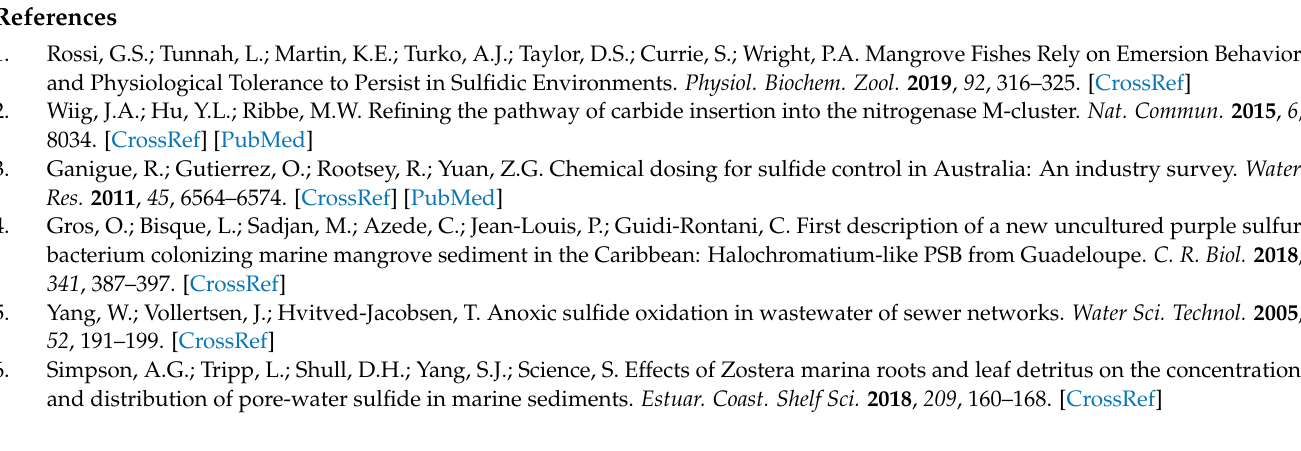
genes enriched in the NMS; Figure S4: Taxonomic classification of key functional genes retrieved Figure S5: Taxonomic classification of key functional genes retrieved from the samples. (A) cysK , (B) cysE , (C) sqr ; Table S1: Functional gene abundances; Table S2: Impact of sediment properties on dissimilating sulfate-reduction gene families; Table S3: Sediment properties in mangrove samples and non-mangrove samples; Table S4: Sediment properties in rhizosphere samples and non-rhizosphere samples; Table S5: Partial Mantel test to evaluate the relative importance of sediments variables in determining microbial communities and the distribution of sulfur genes in subtropical mangrove